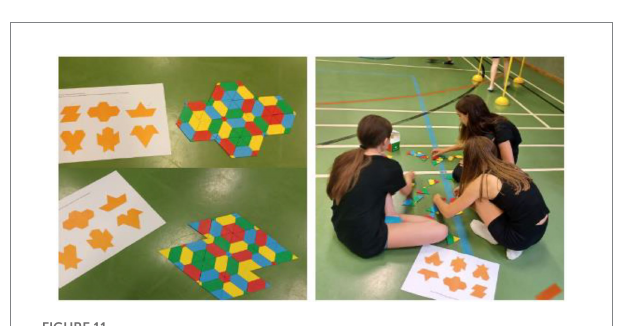
FIGURE 11 Solutions of “Tangram” (Saxon and Stettner, 2019) tasks in